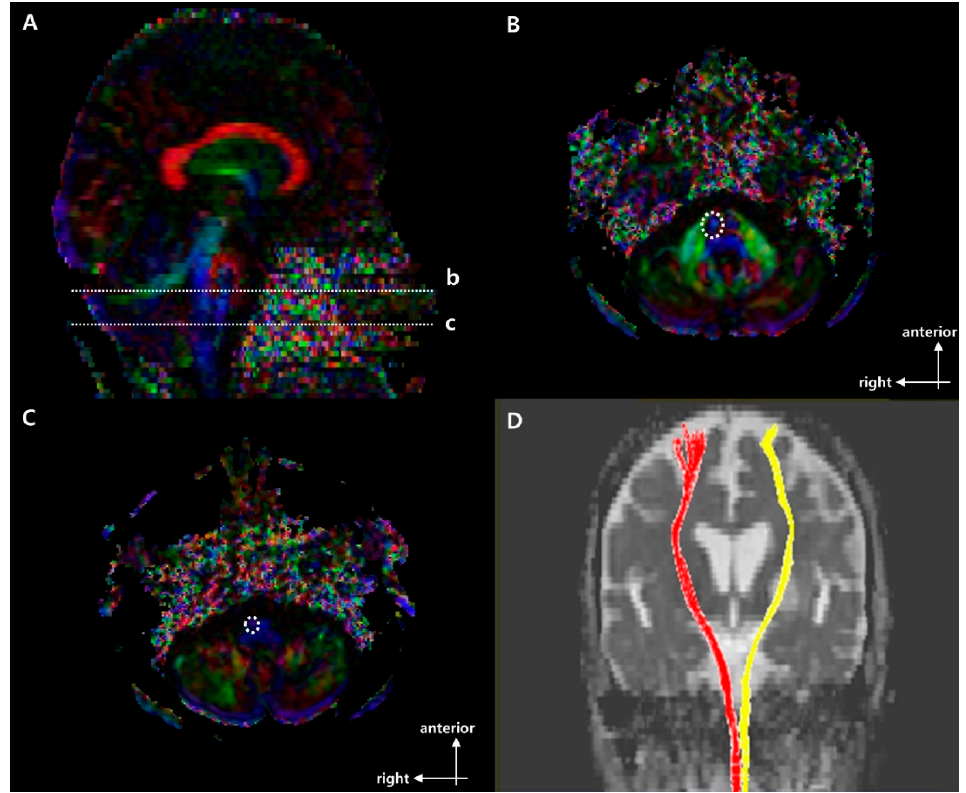
Figure 1. Regions of interest (ROIs used to reconstruct the right corticospinal tract (CST) on DTI and representative diffusion tensor tractography (DTT) images of corticospinal tract (CST). ( A ) Sagittal color fractional anisotropy (FA) map with dotted lines at (b) the mid-pons and (c) the pontomedullary junction. ( B ) The dotted line indicates the target ROI of the CST at the mid-pons in the axial color map (level b in ( A )). ( C ) The dotted line indicates the seed ROI of the CST at the pontomedullary junction in the axial color map (level c in ( A )). ( D ) Representative DTT image of CST in a typical subject with a left middle cerebral artery (MCA) infarction (red, unaffected side; yellow, affected side).